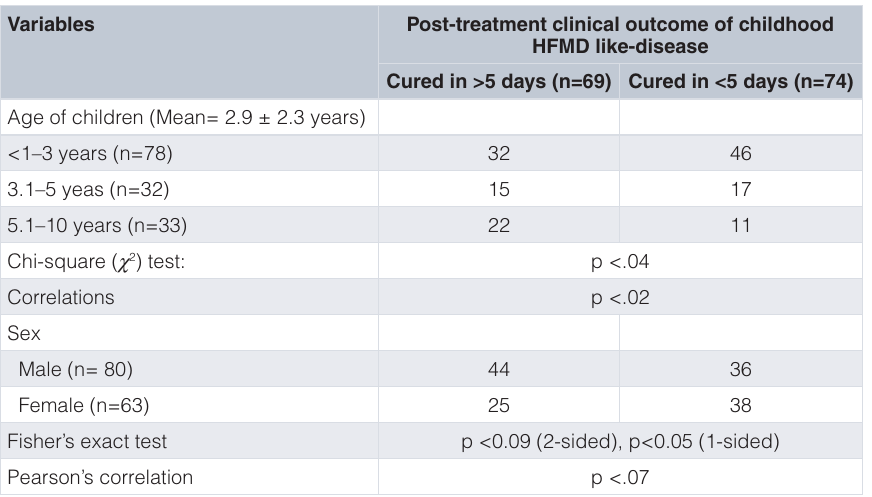
Table 4. Composite table showing association of HFMD clinical features with season/local